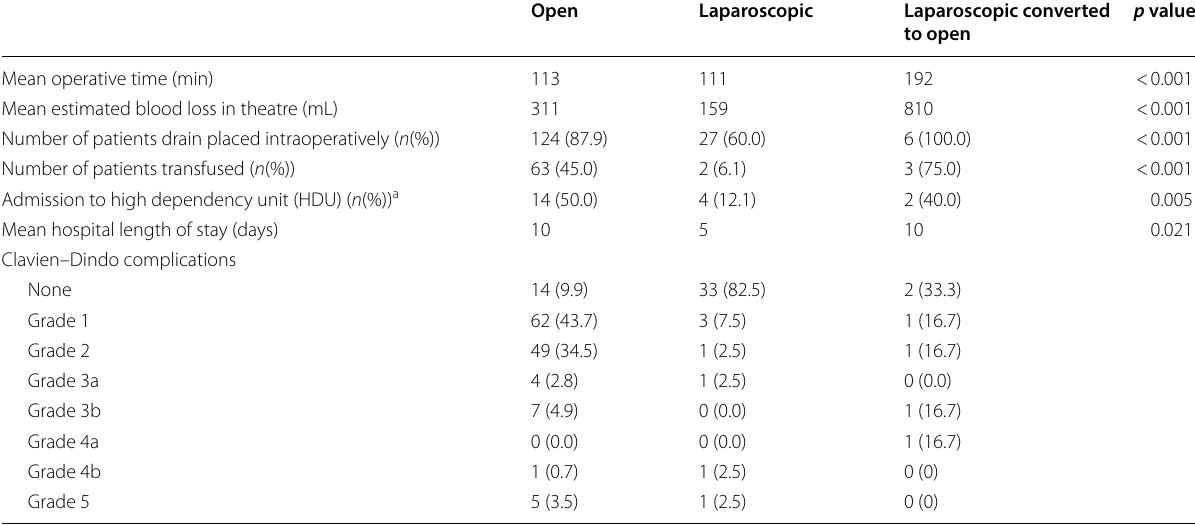
Table 4 Intra- and post-operative outcomes